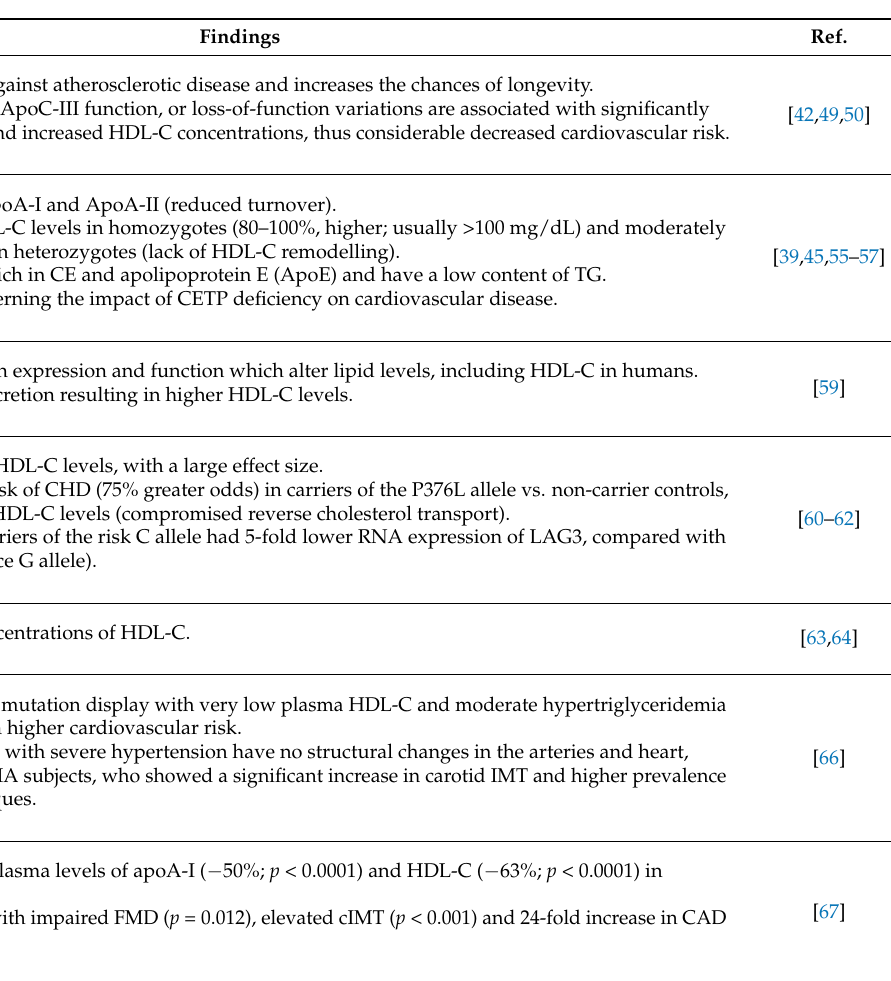
Table 1. Conditions associated with altered levels of